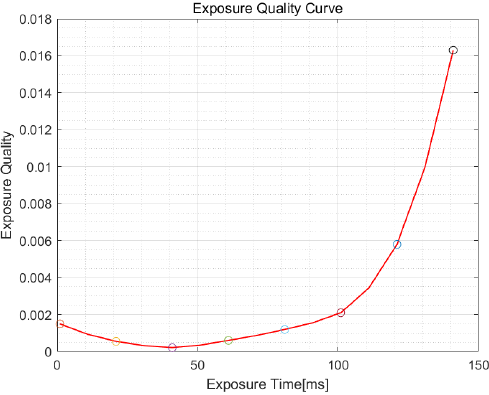
Figure 4. Curve of exposure quality under bright